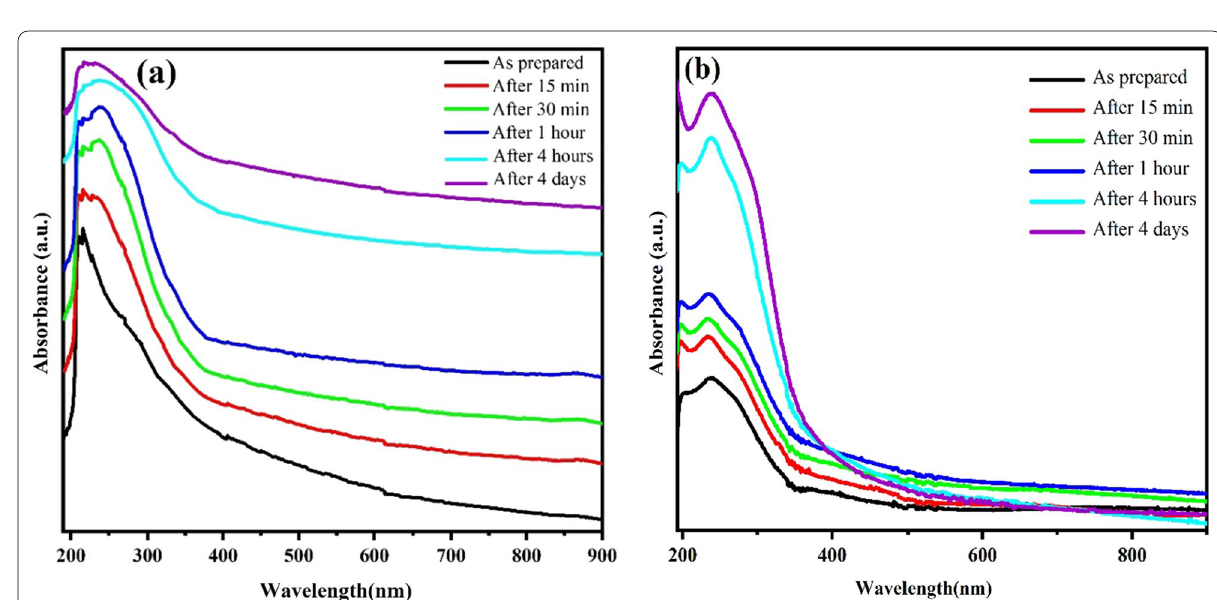
Fig. 6 UV–visible optical absorption spectra of synthesized colloidal samples in a urea solution, b water, over different